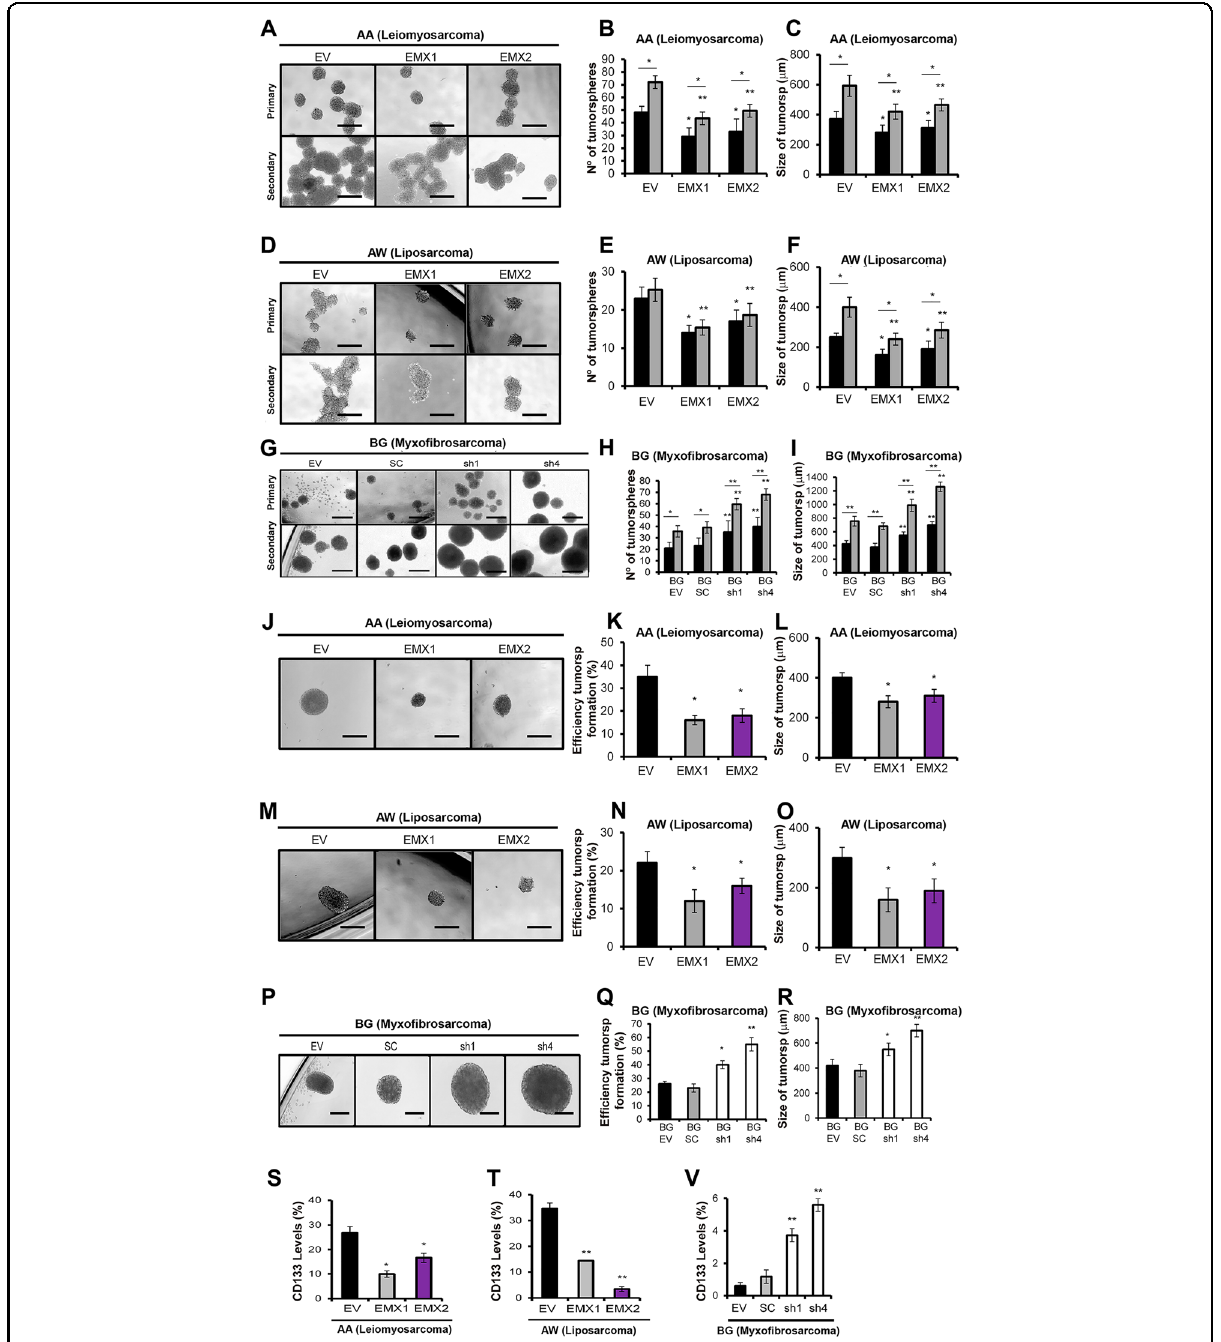
Fig. 3 Effect of different levels of EMX1 and EMX2 on tumorigenesis in sarcoma cell lines. A , D Micrographs of the results of the primary and secondary tumor formation assays in the AA ( A ) and AW ( D ) sarcoma lines with EMX1 or EMX2 overexpression or in the BG cell line with EMXs downregulated by shRNAs ( G ). B , E , H Average number of primary (black bars) and secondary (gray bars) tumorspheres in AA ( B ), AW ( E ), and BG ( H ). In C , F , I , the mean sizes of the primary (bars in black) and secondary (bars in gray) tumors of AA ( C ), AW ( F ), and BG ( I ) are shown. J , M , P Representative images of tumor formation from isolated cells in the AA ( J ), AW ( M ), and BG ( P ) cell lines with different levels of EMX proteins. Sphere- formation ef fi ciency of single cells for AA ( K ), AW ( N ), or BG ( Q ). Size of tumorspheres formed from an isolated cell in AA ( L ), AW ( O ), or BG with different levels of EMX proteins. All bars correspond to 500 µm. The mean of three independent experiments is represented in triplicate ± SD. Statistical analysis was performed with Student ’ s t -test (* p < 0.05; ** p < 0.01; *** p < 0.001). S , T , V Effect of EMX1 and EMX2 levels on the percentage of CD133 + cells in sarcoma cell lines with different levels of EMX proteins. Graphs of the percentage of expression of the CD133 marker (conjugated with PE: CD133-PE), measured by FACS in the different models of lines AA ( S ) and AW ( T ) or BG ( V ) with different levels of EMX